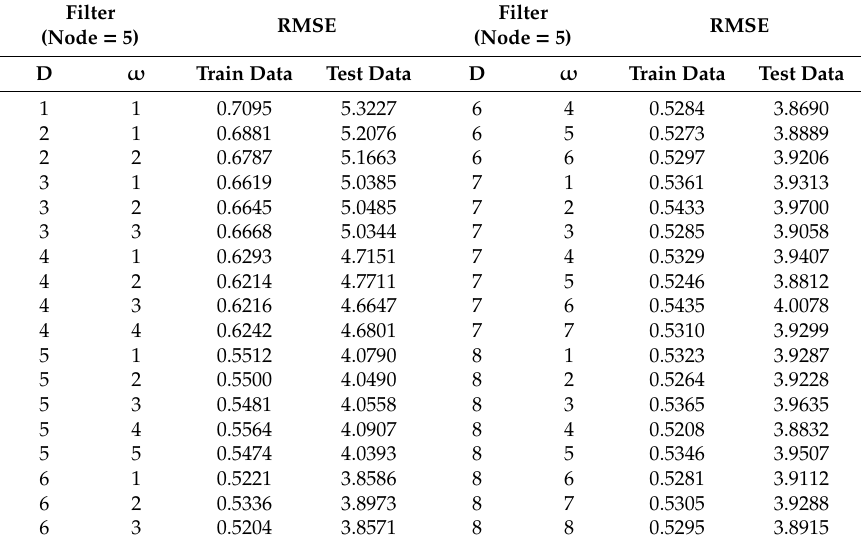
Table 9. RMSE according to D and ω .